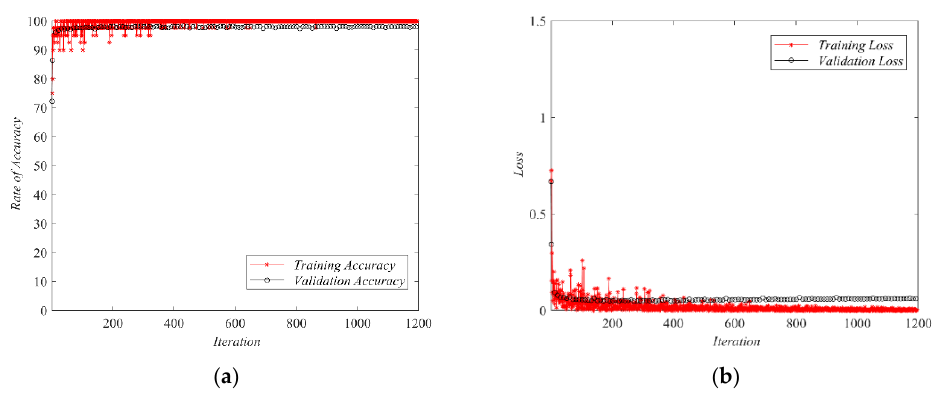
Figure 7. Accuracy and loss results for WMNet training. ( a ) Accuracy and ( b ) loss.